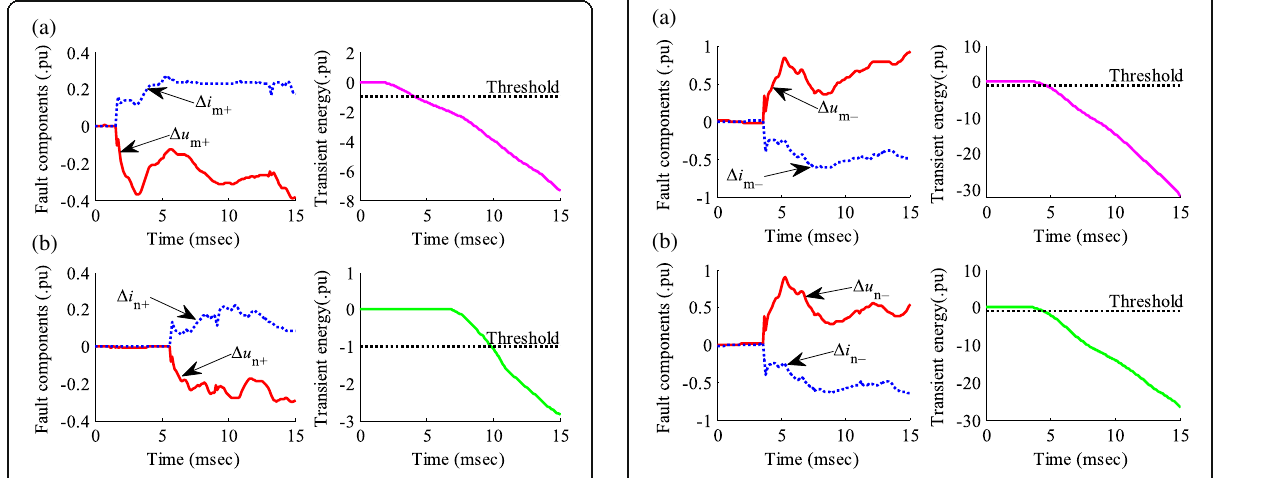
Fig. 8 Waveforms of fault components and transient energies detected on the negative pole line for a fault at F 2. a Rectifier station. b Inverter